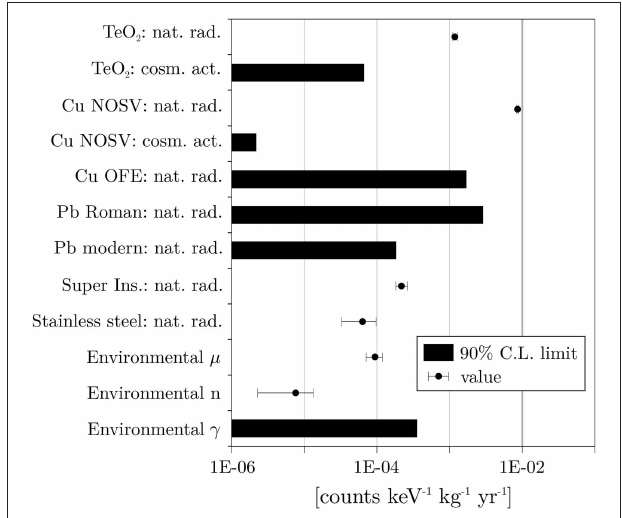
FIGURE 5 | Histogram with the main BI components expected for CUORE. The bars indicate upper limits (90%C.L.), while the markers derived values (with 1 σ uncertainty). The thick line marks the CUORE background target. Figure from Alduino et al.